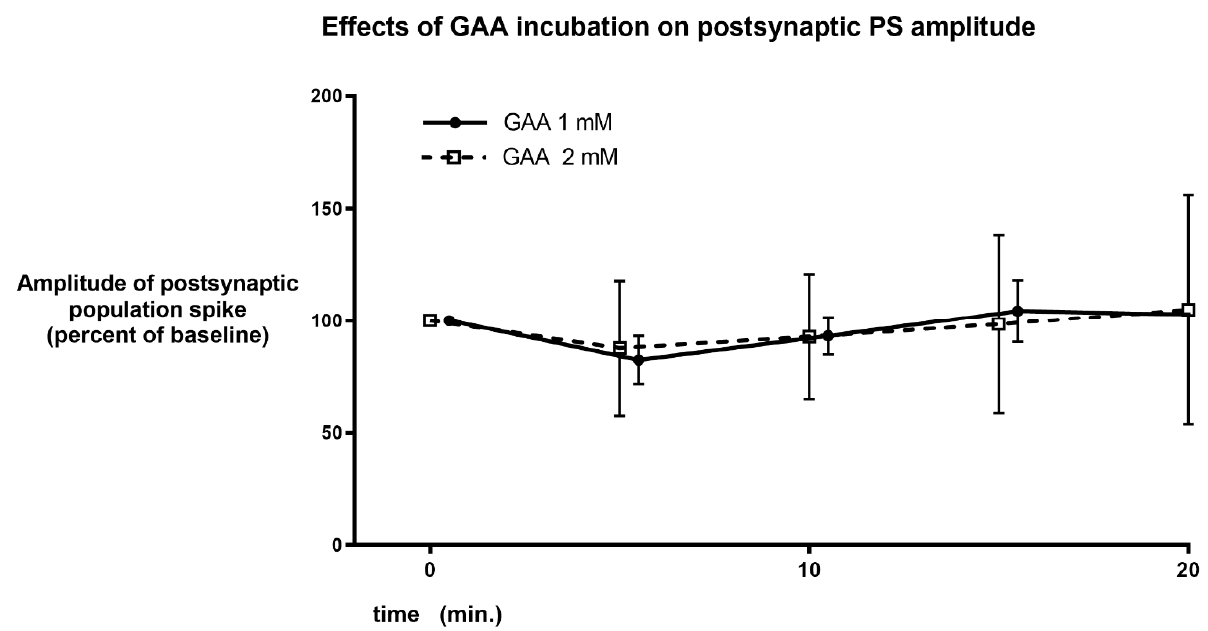
Figure 5. Same parameters and graph as in Figure 4, using higher concentrations of GAA. No change in PS amplitude is evident during GAA incubation.